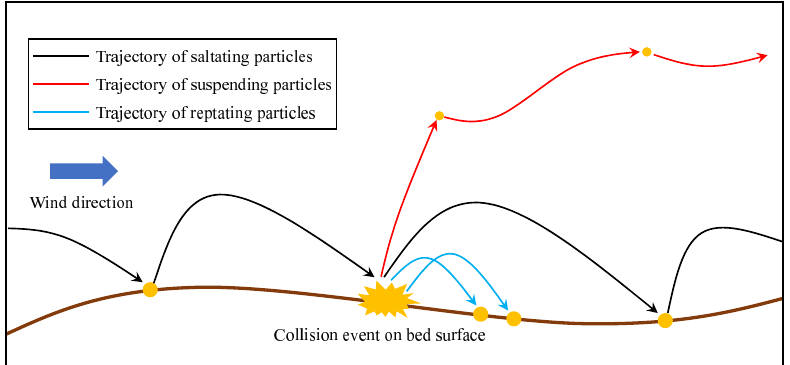
Figure 1. A sketch of the main particle transport forms in the aeolian particle transport